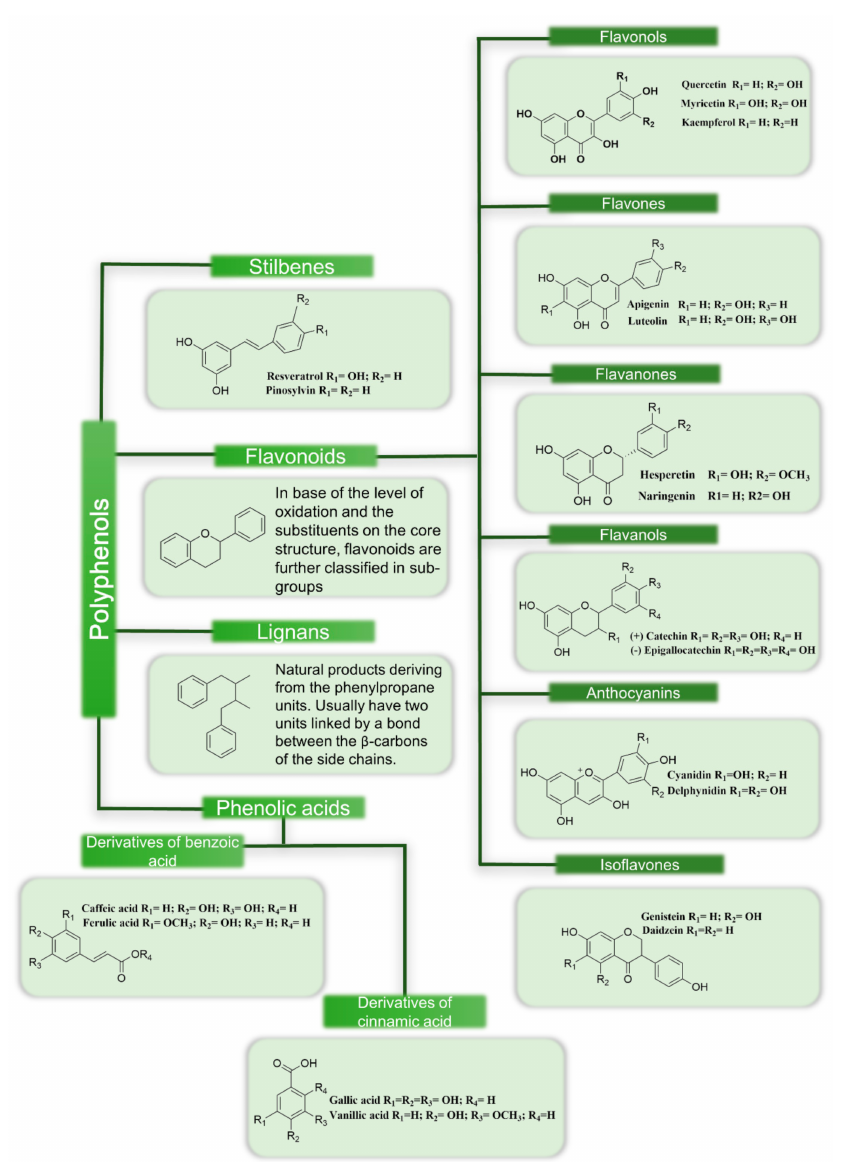
Figure 2. Schematic showing the classification of